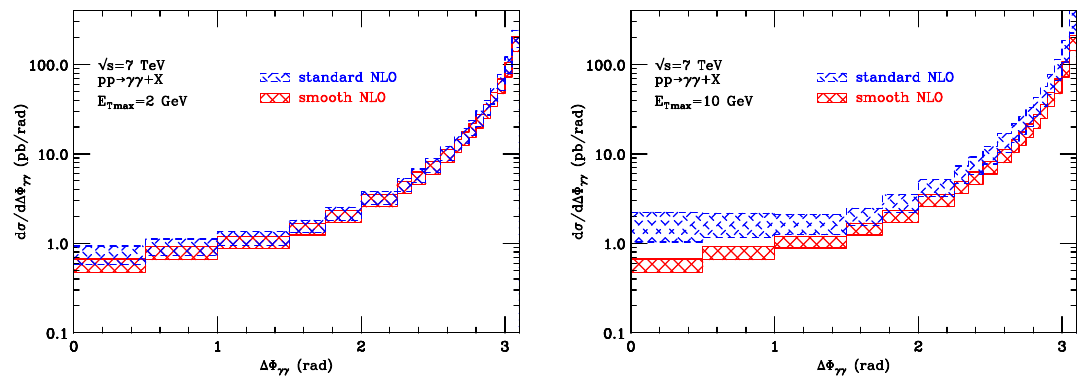
Figure 7 . The NLO results (scale variation bands) for the ∆Φ γγ differential cross section that are obtained by using the smooth (red solid band) and standard (blue dashed band) cone isolation cri- teria with E T max = 2 GeV (left panel) and E T max = 10 GeV (right panel). The photon kinematical cuts are the same as in figure